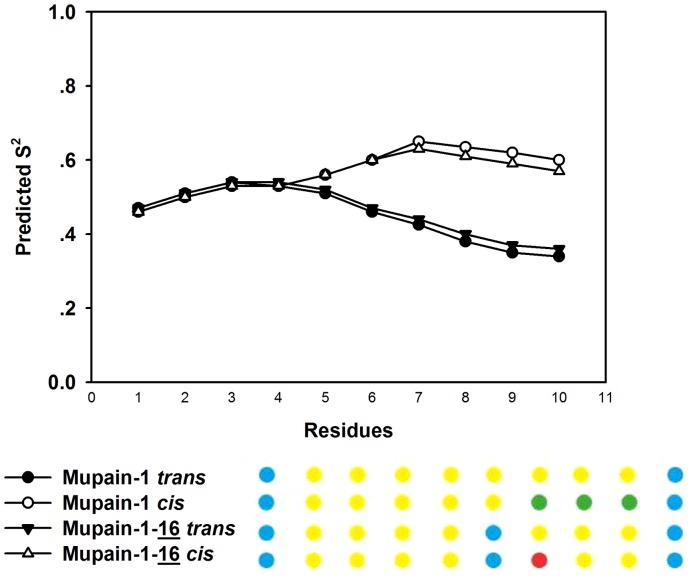
Predicted order parameter S2 (top) calculated by TALOS+.The dots (bottom) represent classification of the residue from TALOS+, as based on the mobility of the backbone, the certainty of the angles of the reference triplets and whether the angles fall into allowed regions in the Ramachandran plot [34]. The colour codes represent good (green), dynamic (yellow), ambiguous (red), and no prediction (blue) for the two different peptides in cis and trans conformations.